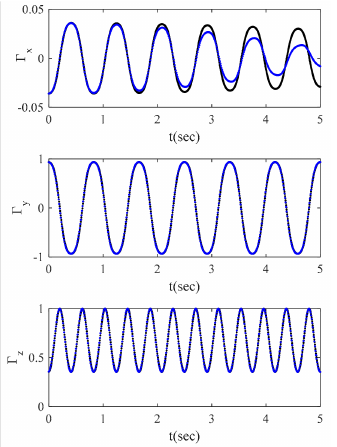
Figure 27. The attitude results under Lie algebra